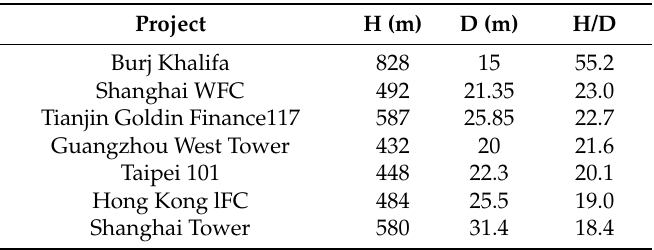
Table 2. Super-tall buildings’ embedded foundation depth